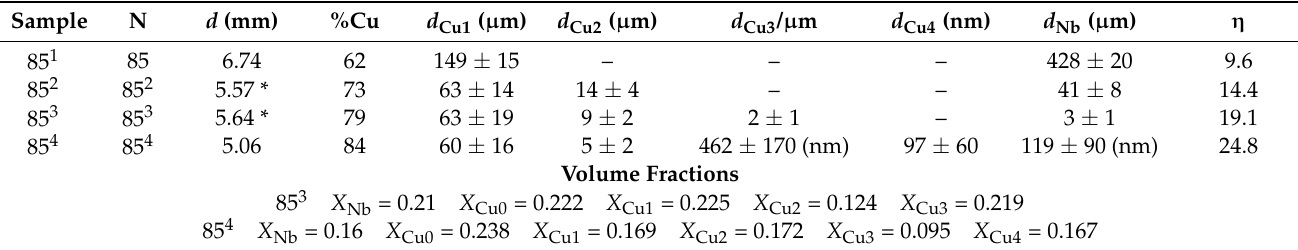
Figure 1. SEM micrograph showing the multi-scale microstructure of N = 85 4 Cu-Nb microcomposite wires. In the maximum magnification view, the Nb fibers exhibit light contrast embedded in a dark-contrast Cu matrix (removed by etch). Table 1. Dimensional characteristics of the selection of Cu-Nb